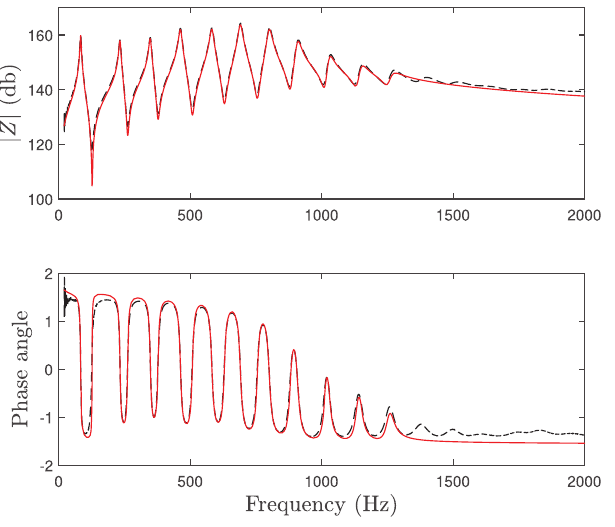
Figure 2. Bifurcation diagram (peak-to-peak amplitude of p with respect to p 0 ) of the periodic branch of solution for a B [ 4 (470 Hz). The dotted line indicates the unstable part of the solution branch, while the solid line indicates the stable part of the branch. s : Hopf bifurcation ( p H point), r : fold, D : | p | at the Hopf bifurcation, h : | p | when p 0 = 5 kPa. Table 2. Lip parameters used for the numerical continuation of the